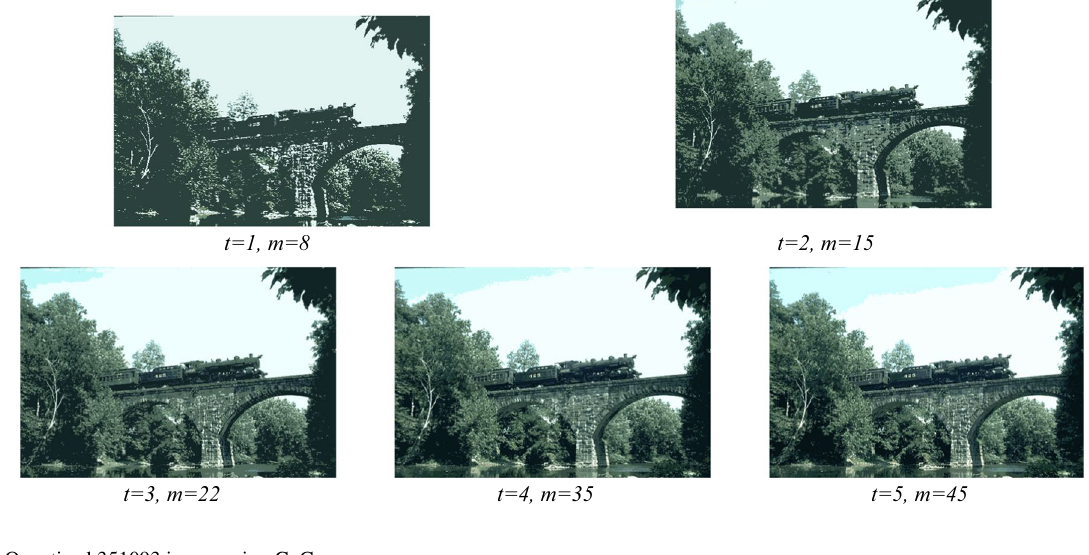
Fig. 12 Quantized 351093 image using CoG